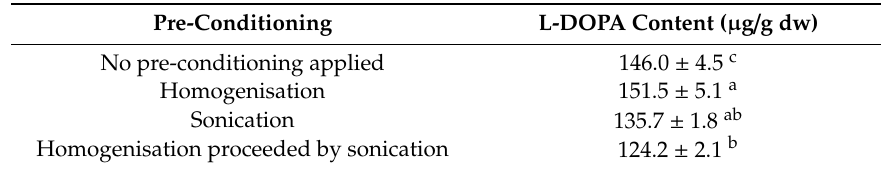
Table 3. Influence of sample homogenization A and sonication B as well as of their combination, i.e., homogenisation followed by sonication, on the e ffi ciency of subsequent l -DOPA extraction C from dry beans of V. faba var. major